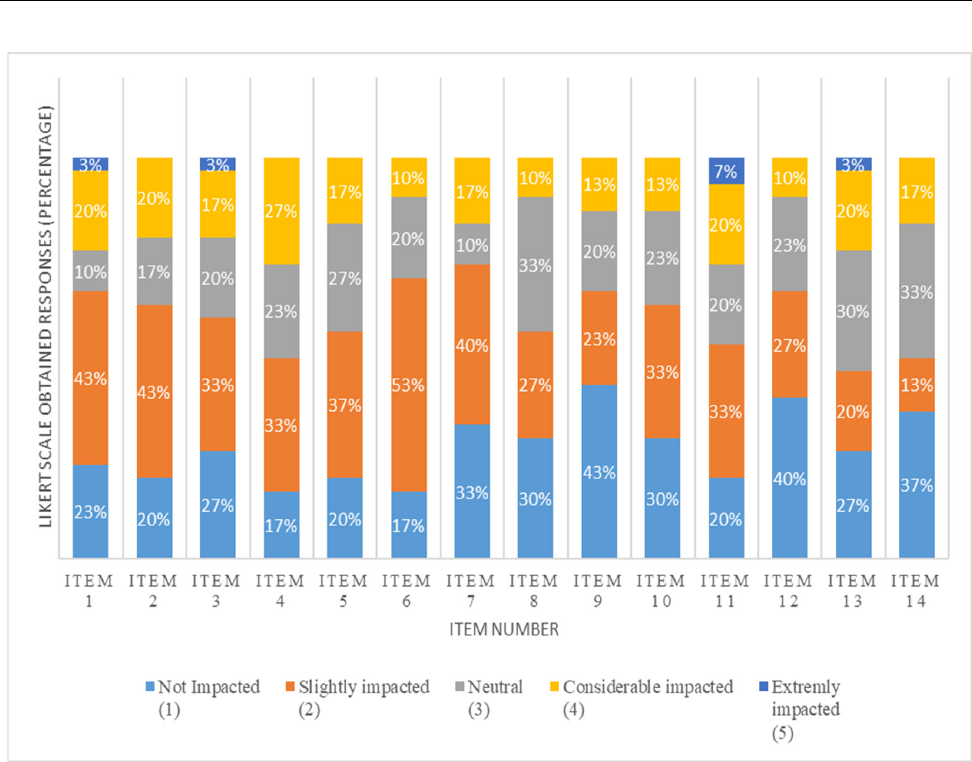
Figure 4. COVID-19 potential effects response obtained.